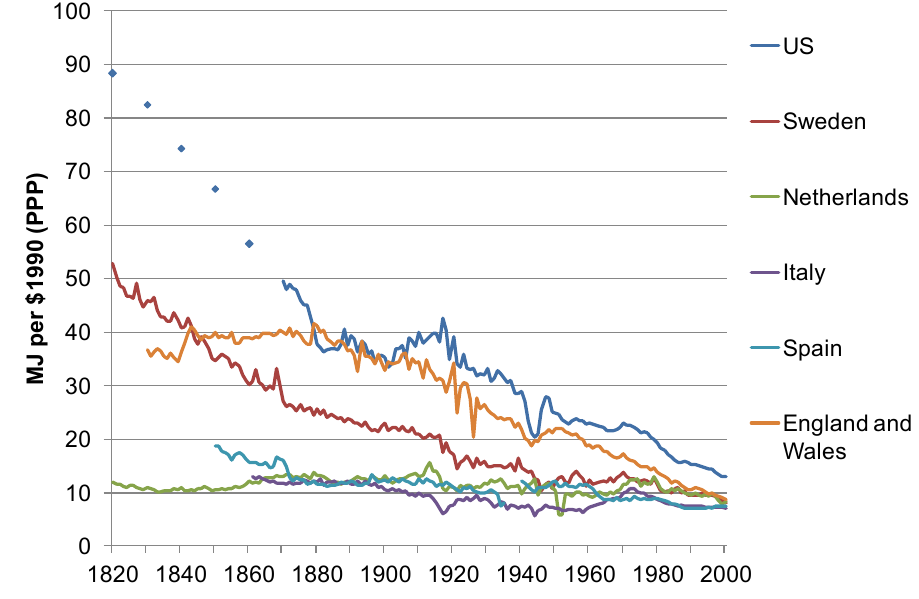
Figure 18. Energy intensity in selected countries, 1800–2000. Sources: [4] for Sweden, The Netherlands, Italy, and Spain; [77] for England and Wales; this analysis for